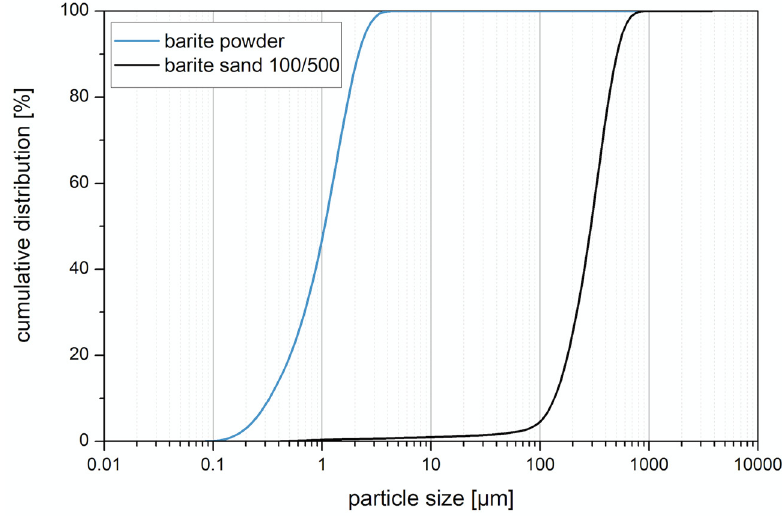
Figure 8. Tracers with different grain sizes.